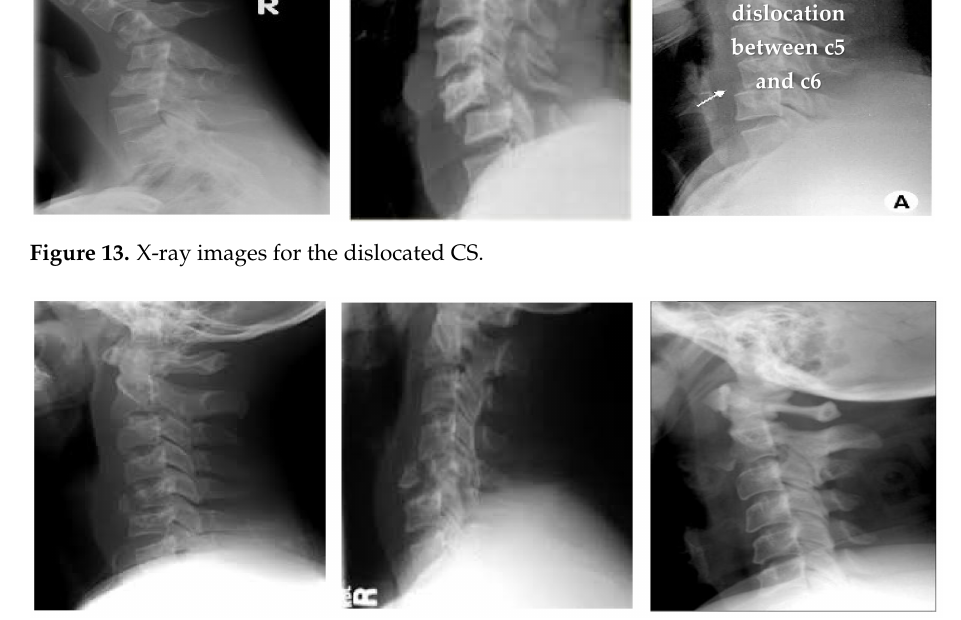
Figure 14. X-ray images for the fractured CS.